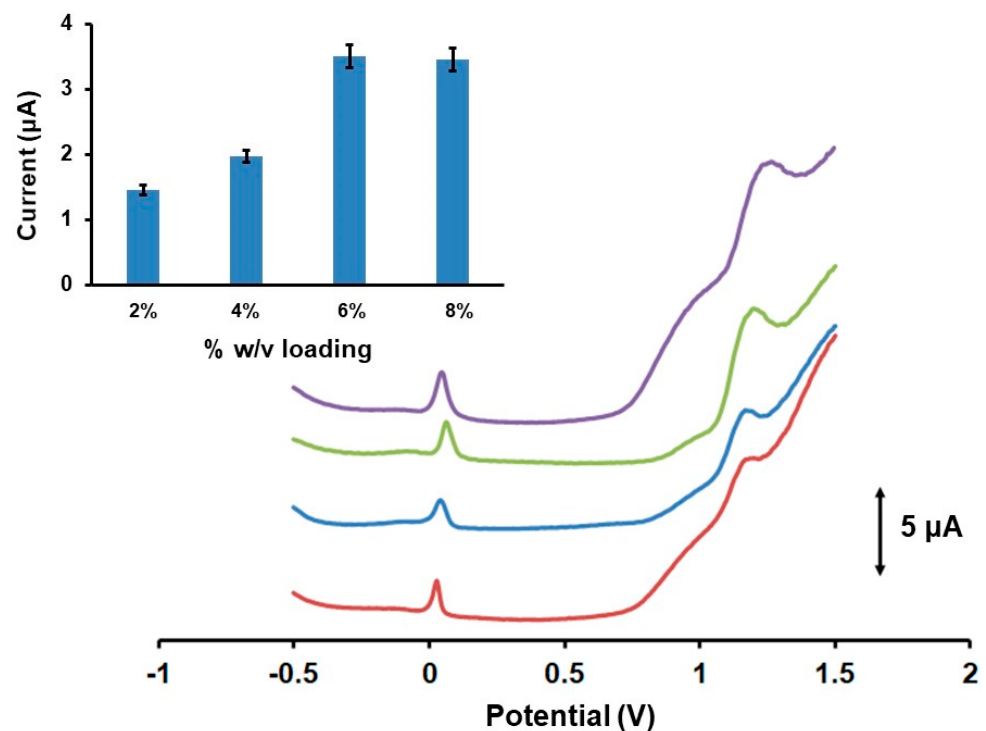
Figure 5. Effect of the concentration of the Fe 3 O(PhCO 2 ) 6 (H 2 O) 3 ] · PhCO 2 at the 3DPE on the DPV peak current values of 200 µ mol L − 1 GLU in 0.1 mol L − 1 PB (pH 4) and the respective DPV responses (from down to up 2, 4, 6, 8% ( w / v )). Each bar is the mean value ± SD ( n = 3). Reduction of Fe(III)-cluster at − 1.4 V for 360 s.